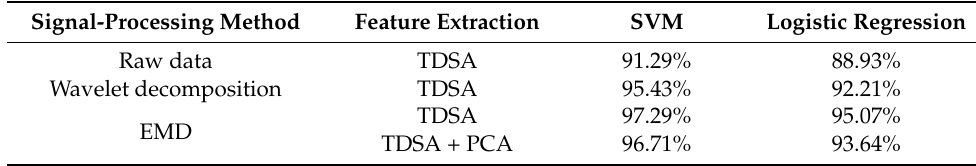
Table 4. Accuracies of various combinations of